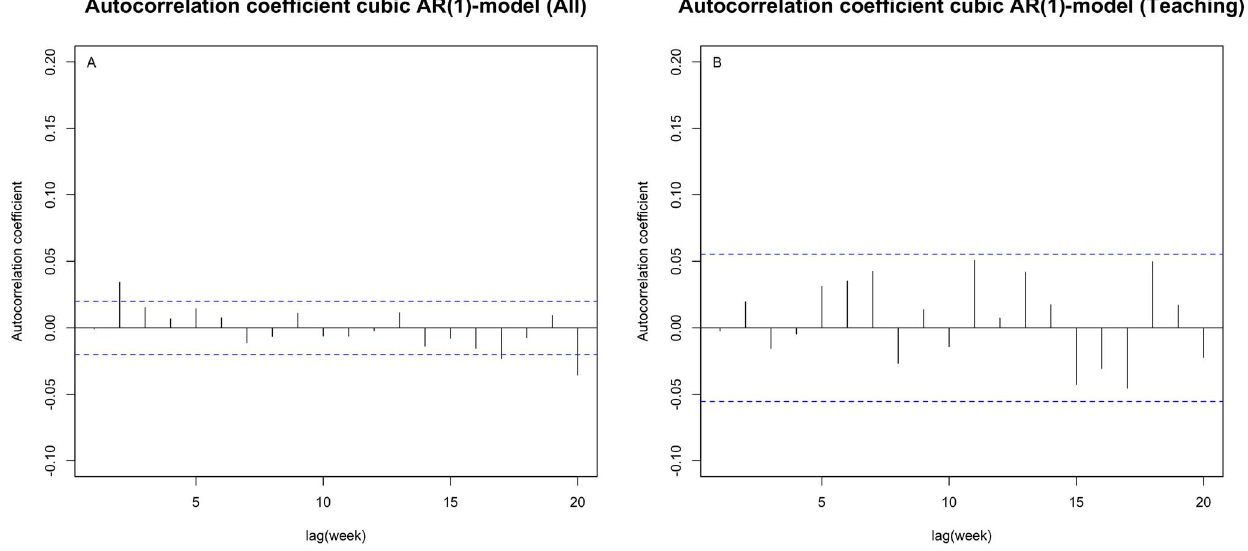
Figure 3. Dependence between observed weekly number of CDI – AR1-model. A and B: autocorrelation function (ACF) of normalized residuals of the AR1-model fitted to data of all hospitals ( A ) and of teaching hospitals only ( B ) including a fitted cubic representation of the CDI trend over time and seasonality. As in figure 2, the blue lines correspond to the threshold for significance of correlation (dependence) (p , 0.05) between lagged weekly observations up to week 20. Crossing of this threshold by the AR1-model residuals at lag 2 suggests the AR1 structure (symptomatic cases primarily cause acquisition of C. difficile among patients admitted to hospital up to one week later and, to a lesser extent, to cases admitted beyond this time), does not fully explain the dependence structure between weekly observations.